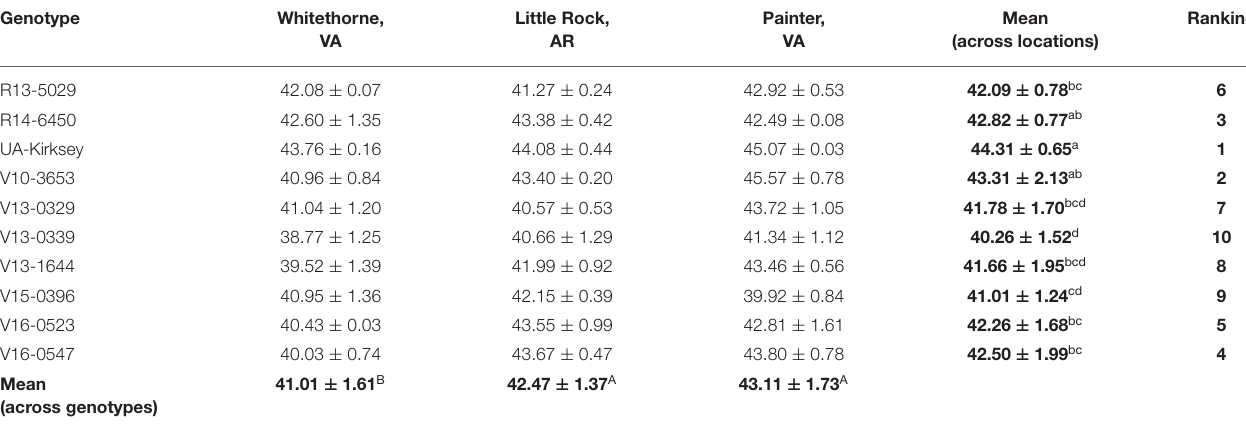
TABLE 6 | Crude protein contents [%, dry basis (d.b.)] of 10 edamame genotypes planted in different locations. Genotype Whitethorne,